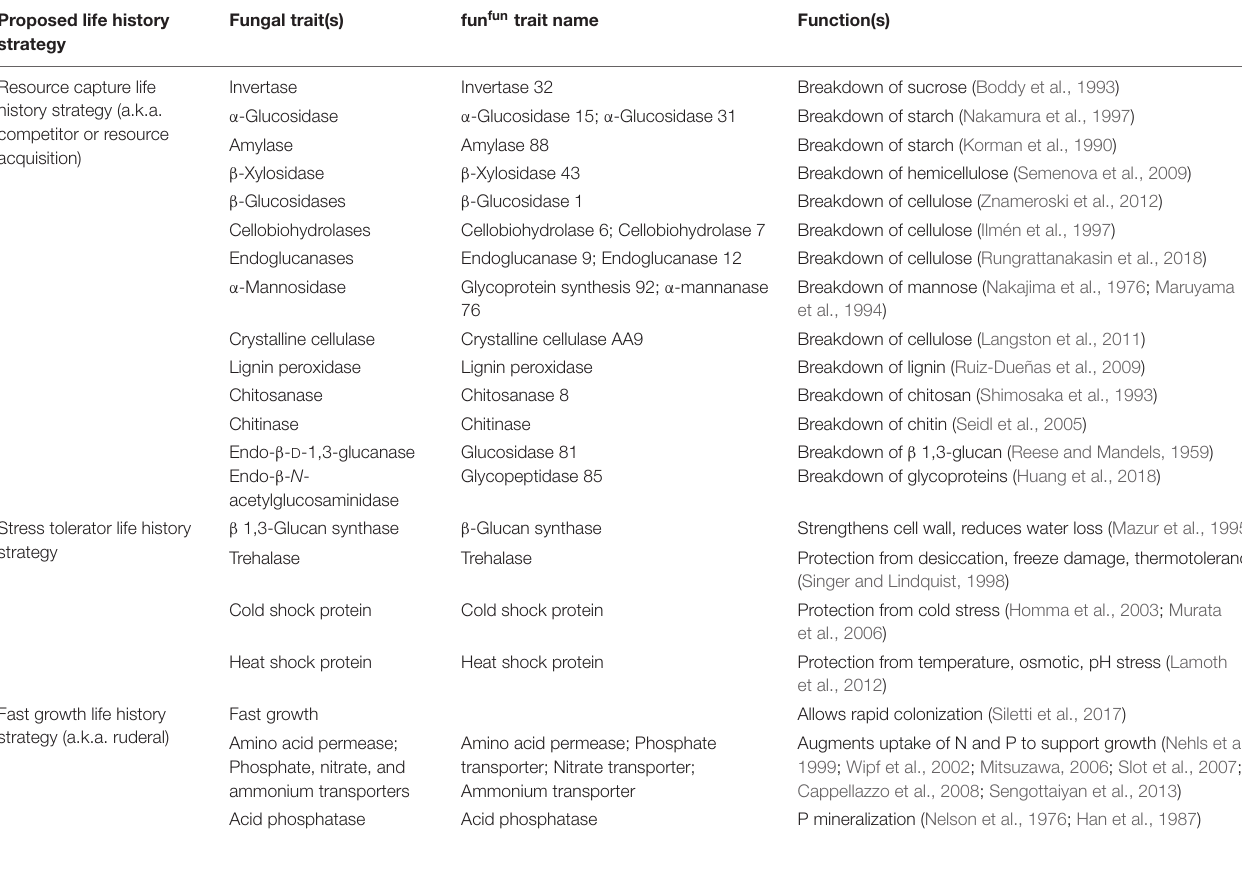
TABLE 1 | Potential fungal traits associated with each life history strategy within the Competitor-Stress Tolerator-Ruderal scheme. Proposed life history